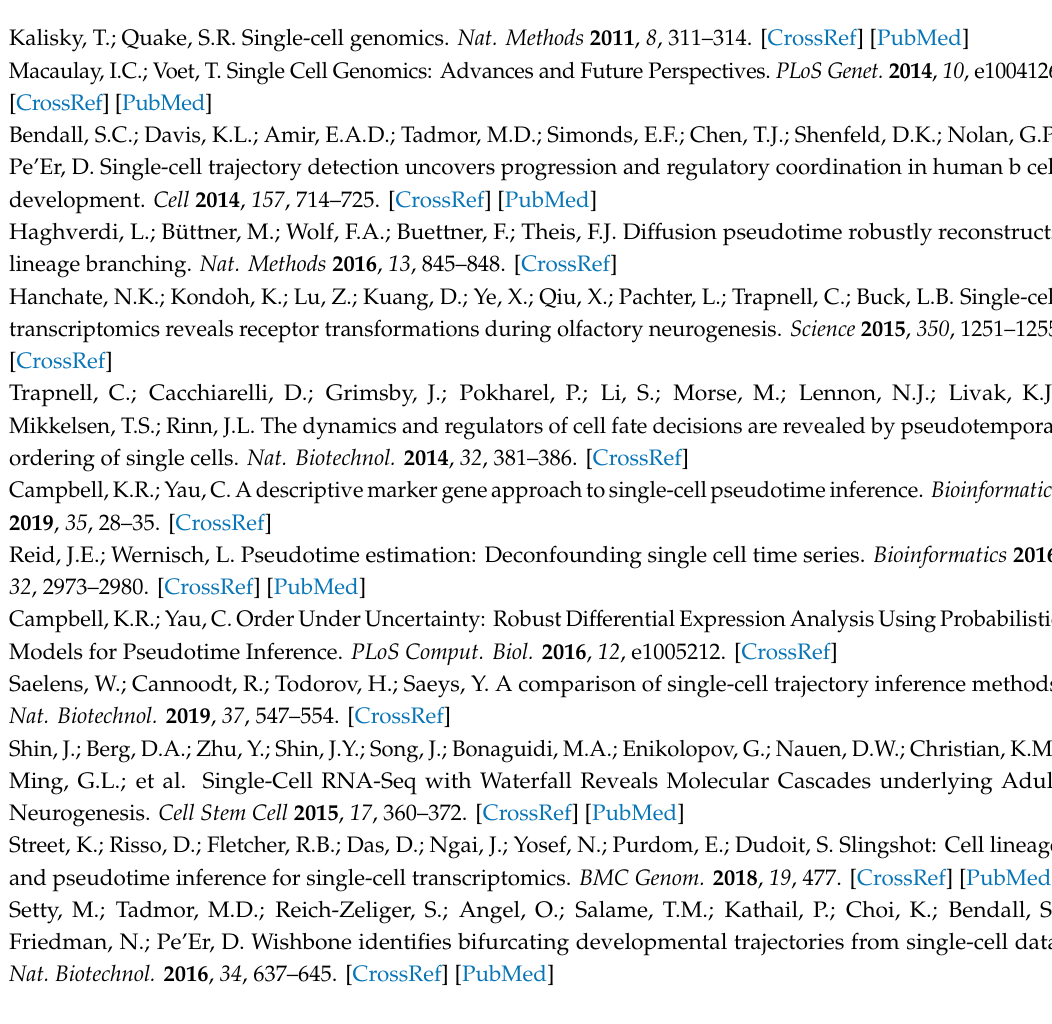
Figure S1: Cellular markers and previous signatures of planarian single cell transcriptome, Figure S2: Positions of selected genes are shown in the map together with their expression profiles, Figure S3: Profiles and maps of tissue-wise di ff erentially expressed genes and gene sets which were identified by [29], Table S1: References of selected marker genes of Figure S1, Table S2: Overview of module-wise enriched gene sets of the GO terms Biological Process, Cellular Component, Molecular function and Protein